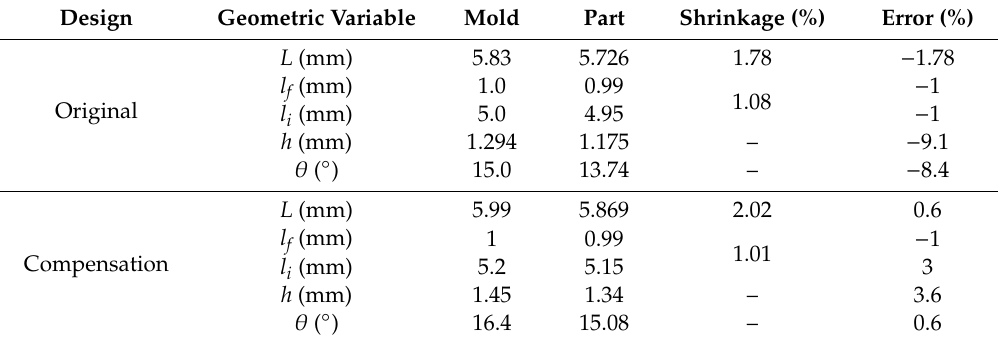
Table 2. Dimensions of mold and molded parts of the original and the compensated mold, whose errors were obtained by comparing original design dimensions.